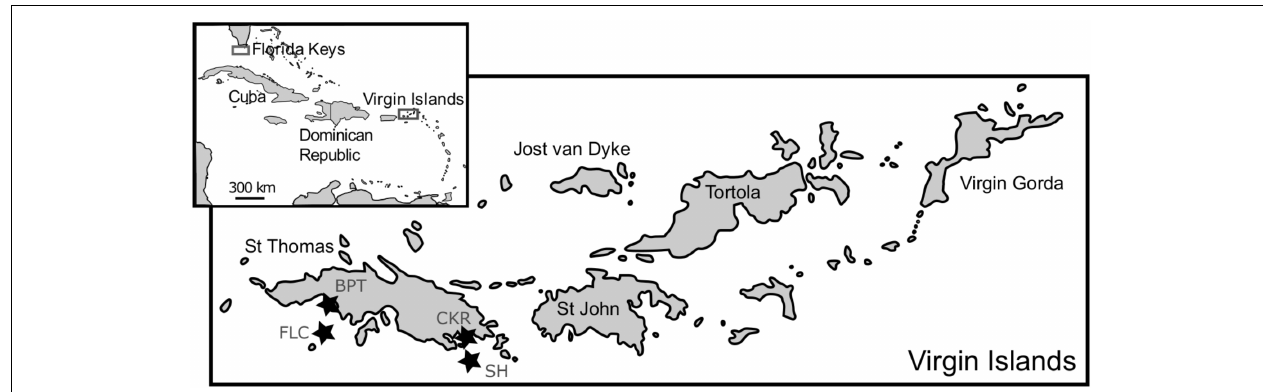
FIGURE 1 | Map of sampling locations in the Florida Keys and St. Thomas, US Virgin Islands. The four sampling sites Black Point (BPT, Lat: 18.34450, Long: –64.98595), Coculus Rock (CKR, Lat: 18.31257, Long: –64.86058), Flat Cay (FLC, Lat: 18.31822, Long: –64.99104), and Seahorse (SH, Lat: 18.29467, Long: –64.86750) at St. Thomas are indicated with stars and are part of the Territorial Coral Reef Monitoring Program, with details and ancillary data found in Smith et al. (2016).